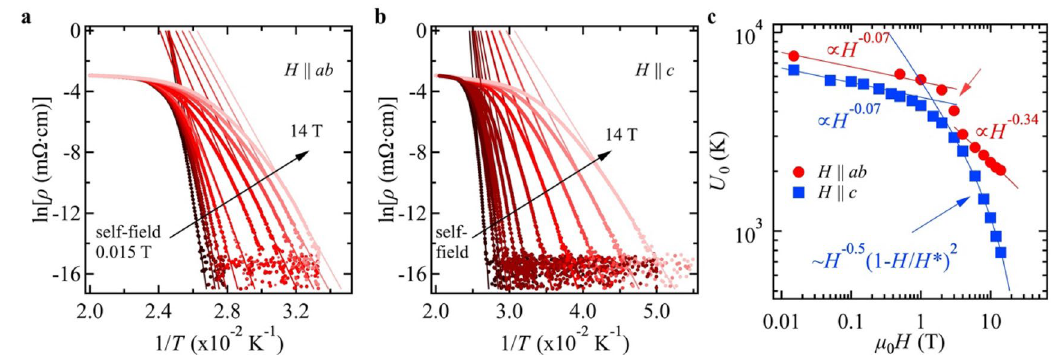
Figure 3. Arrhenius plot of the field dependence of the resistivity traces shown in Fig. 2. Applied field parallel to ( a ) the ab -plane and ( b ) c -axis. ( c ) Field dependence of the activation energy U 0 of thermally assisted flux motion for both main crystallographic directions. The exponent α for H || ab changes from 0.07 to 1 between 2 and 4 T, as indicated by a red arrow, before again changing to